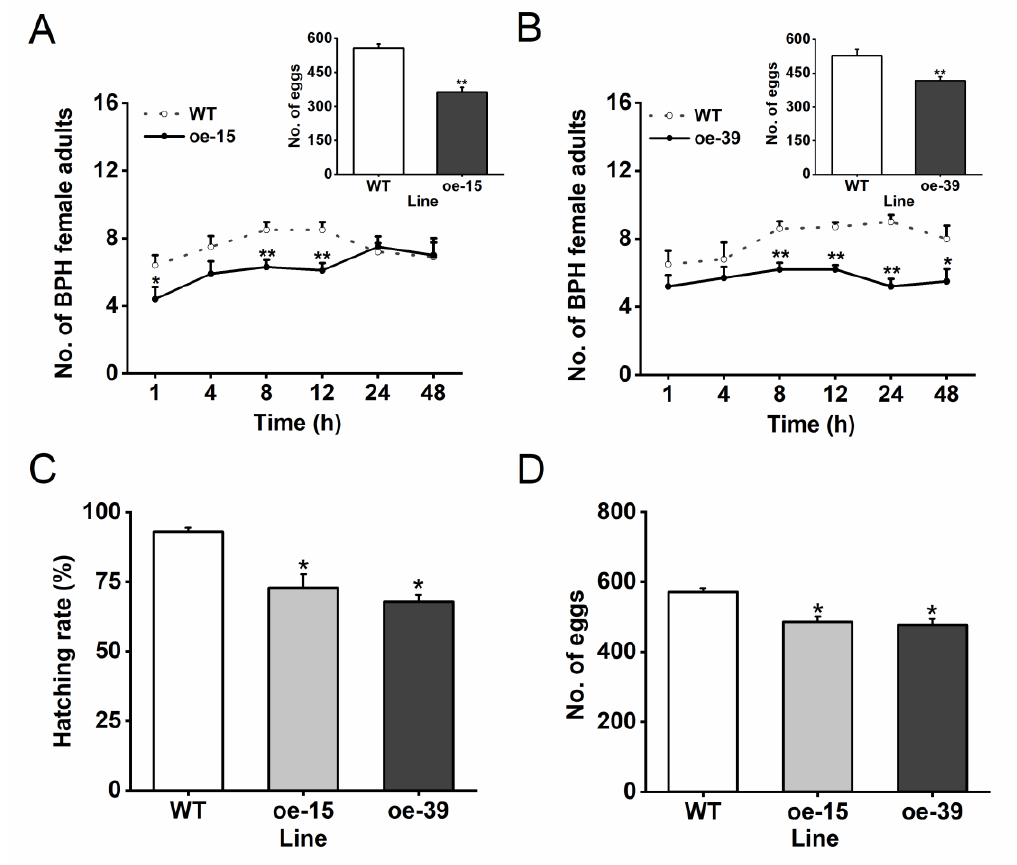
Figure 7. Os6PGDH1 positively regulates rice resistance to BPH. ( A , B ) Mean number ( + SE, n = 10) of gravid BPH females per plant on pairs of plants (WT versus oe-15 ( A ) and oe-39 ( B )). Insert: Mean number ( + SE, n = 10) of eggs per plant on pairs of plants as stated above. Asterisks indicate significant di ff erences between oe6PGDH and WT plants (* p < 0.05, ** p < 0.01, Student’s t -test). ( C ) Mean hatching rate ( + SE, n = 10) of eggs on oe6PGDH plants and WT plants. ( D ) Mean number ( + SE, n = 30) of eggs laid by one pair of BPH female and male adults that emerged from oe6PGDH or WT plants. Asterisks indicate significant di ff erences in oe6PGDH lines compared with those in WT plants (one-way ANOVA followed by Duncan’s multiple range test, p < 0.05).